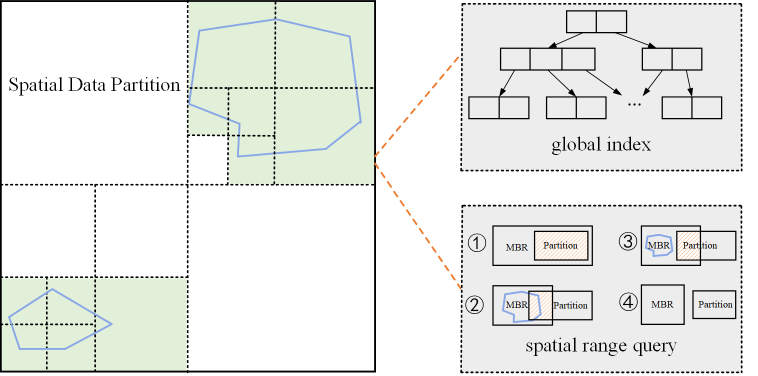
Figure 3. The process of polygonal spatial search. Each spatial partition is a data node of the global index. A polygon query range may spatially overlap with multiple data